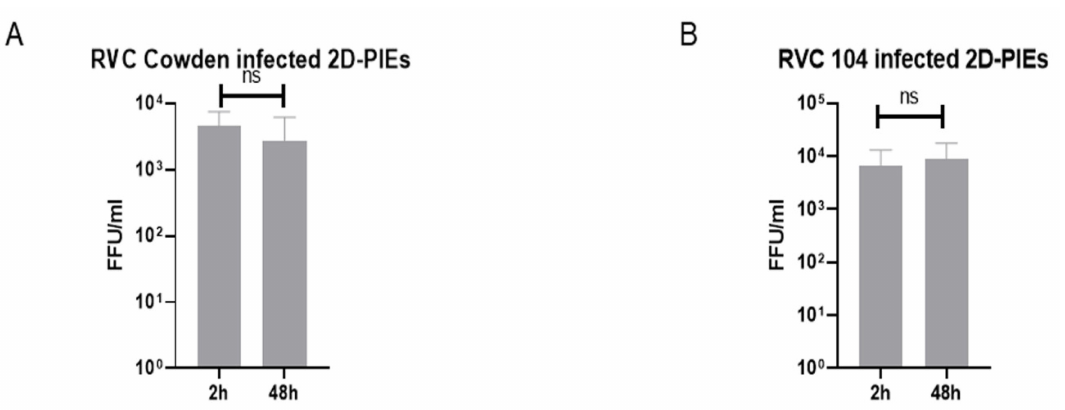
Figure 6. RVC infection of 2D-PIEs. ( A ) Cowden and ( B ) PRVC104-infected 2D-PIE. RV load was examined at 2 h and 24 h. Error bars indicate the standard deviation, and all experiments are 2–3 independent replicates. Capped lines indicate the fold-changes between two groups. ns denotes no significant difference.